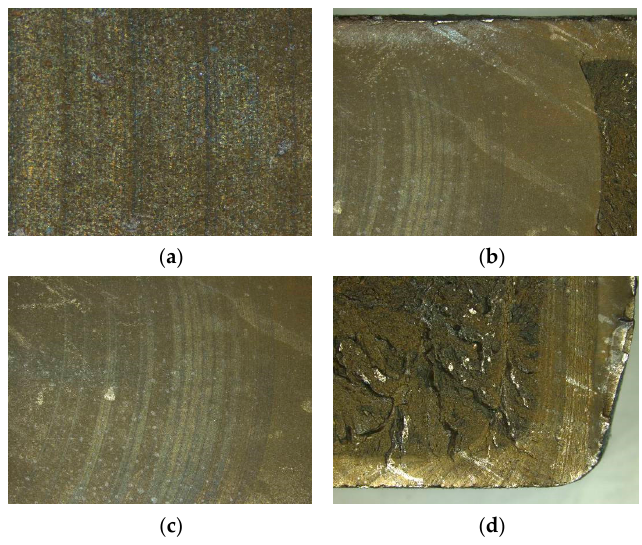
Figure 3. Boom fracture body view. ( a ) Pre-extension region; ( b ) Mid-term propagation area; ( c ) Late- term propagation area; ( d ) Transient fracture